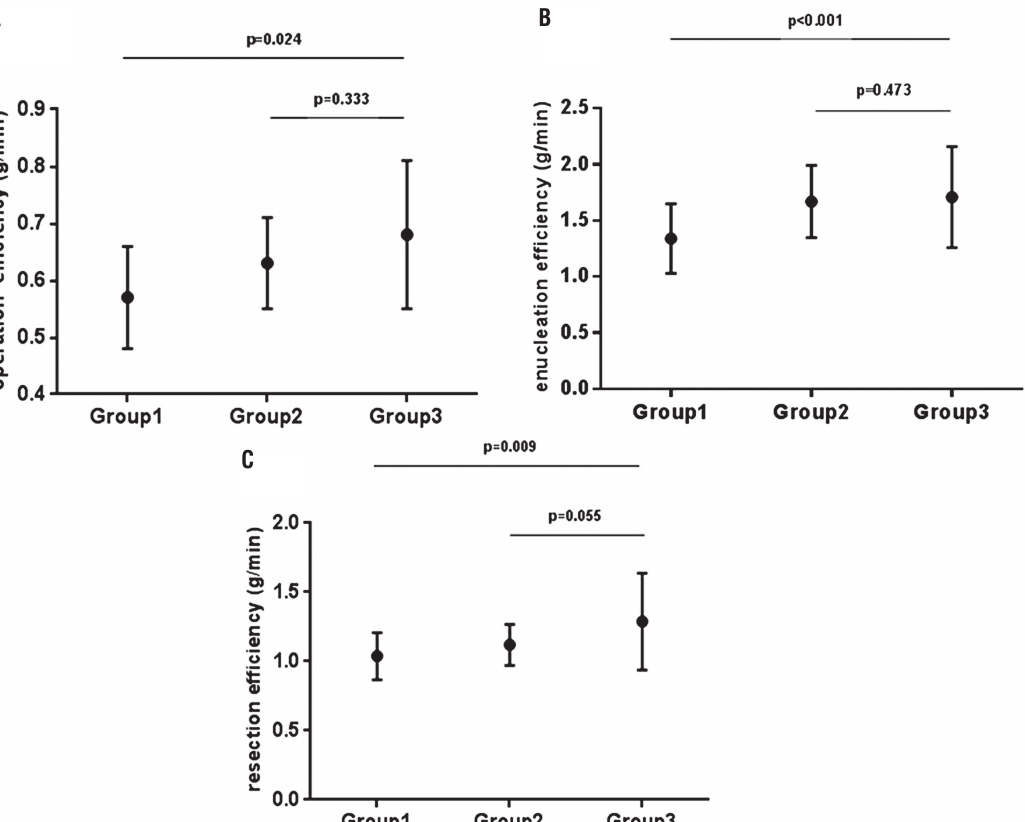
Figura 2 - (A): Comparison of operation efficiency between the three groups; (B): Comparison of enucleation efficiency between the three groups; (C): Comparison of resection efficiency between the three groups. A B